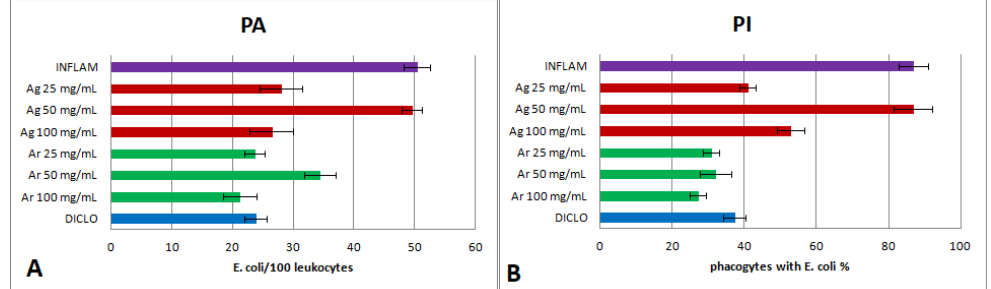
Figure 4. Phagocytosis test parameters. A. Phagocytic activity (PA). B . Phagocytic index (PI). Note: Diclo — animals were given 20 mg/kg BW diclofenac, Inflam — the induction of inflammation was made by intramuscular injection of turpentine oil (6 mL/kg BW), Ag 25 mg/mL — animals were given 5 mL/kg BW A. genevensis ethanol extract 25 mg dw/mL, Ag 50 mg/mL — animals were given 5 mL/kg BW A. genevensis ethanol extract 50 mg dw/mL, Ag 100 mg/mL — animals were given 5 mL/kg BW A. genevensis ethanol extract 100 mg dw/mL, Ar 25 mg/mL — animals were given 5 mL/kg BW A. reptans ethanol extract 25 mg dw/mL, Ar 50 mg/mL — animals were given 5 mL/kg BW A. reptans ethanol